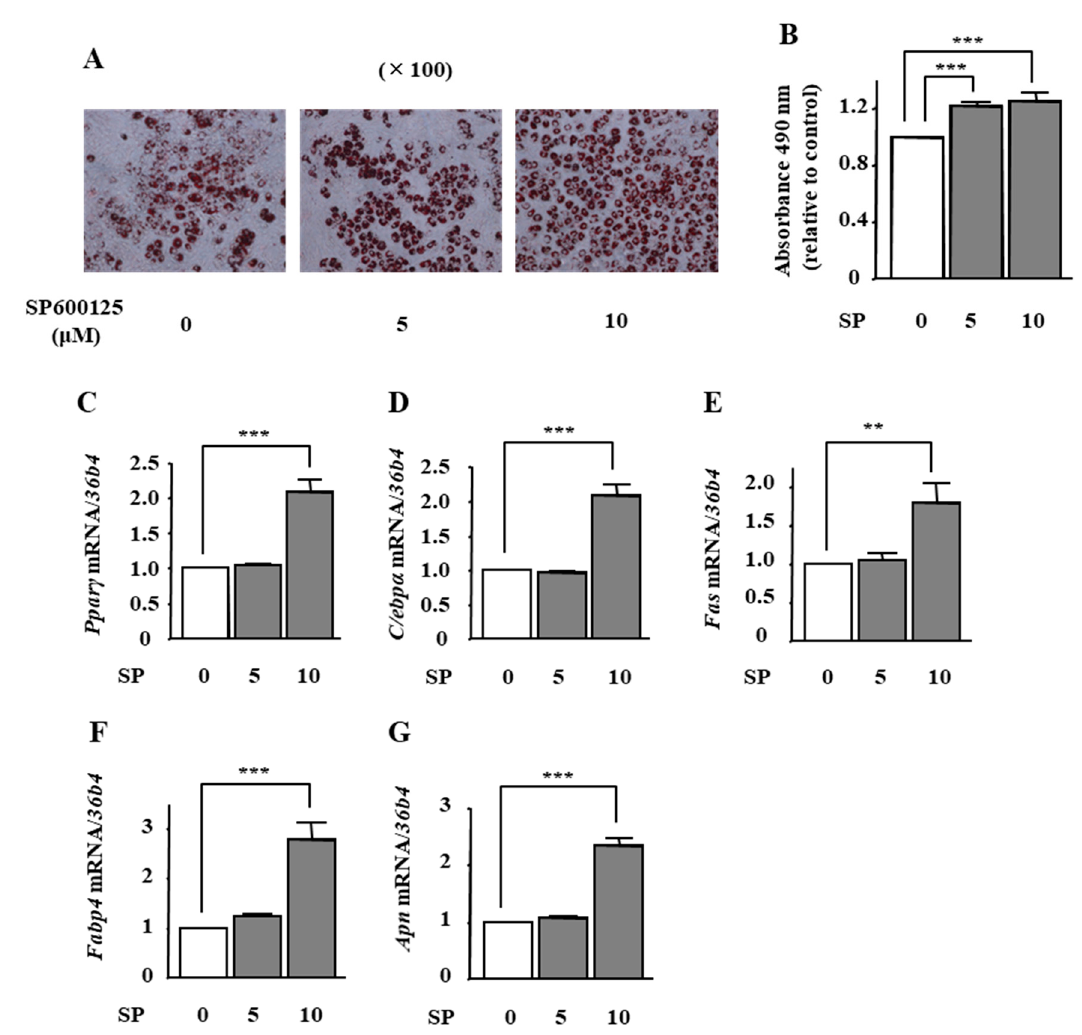
Figure 5. The effects of the JNK inhibitor SP600125 on adipocyte differentiation in ST2 cells. ( A , B ) After reaching confluency, ST2 cells were incubated in adipogenic medium with the JNK inhibitor SP6001215 (0, 5, and 10 µ M) for 8 days. Thereafter, oil red O staining and its quantification were performed. The results are representative of at least seven different experiments. The quantification results are expressed as mean ± SE ( n = 8); *** p < 0.001. ( C – G ) After reaching confluency, the cells were incubated in adipogenic medium with PD98059 (0, 10, and 20 µ M) for 4 days. The mRNA expression of adipogenic differentiation markers ( Ppar γ , C/ebp α , Fas , Fabp4 , and Apn ) was examined by real-time PCR. The results are expressed as mean ± SE ( n = 7); ** p < 0.01, *** p < 0.001. SP: SP600125.